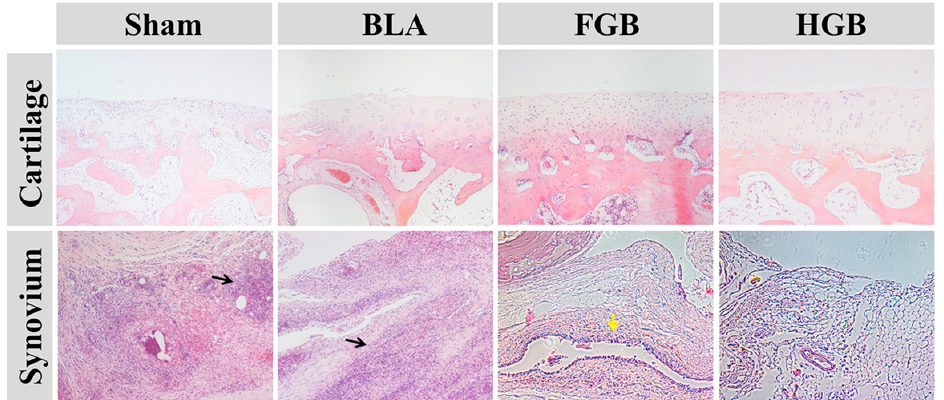
Polymers 2016 , 8 , 182 11 of 15 Figure 8. ( a ) Macroscopic ICRS scores and ( b ) histological ICRS scores of microscopic observation in BLA, FGB, and HGB groups. The results are representative of means ± SD ( n = 5, ** p < 0.01, *** p < 0.001). Despite the positive experimental data demonstrating the significant improvement in cartilage repair in the HGB group compared to those in the other groups, outcomes are still inferior compared to the results of cartilage tissue engineering obtained in the absence of a pro-inflammatory state. 3.5.2. Protection of Tissues Surrounding Cartilage It has been previously reported that the abnormal proliferation of FLSs participate in the pathogenesis of RA under inflammatory states, particularly in the presence of TNF- α or the recruitment of mutable precursor cells [44]. Conversely, FLSs reactively secrete various inflammatory mediators, which can contribute to inflammation and aggravate cartilage destruction [45,46]. The status of cartilage tissue surrounding the defects was examined by histopathological staining in this study (Figure 9). Progressive cartilage destruction and cartilage damage caused by OVA administration were found in the Sham group. As seen in Figure 9, similar findings were observed in the BLA group. The cartilage surface of FGB group was smooth and intact with abnormal